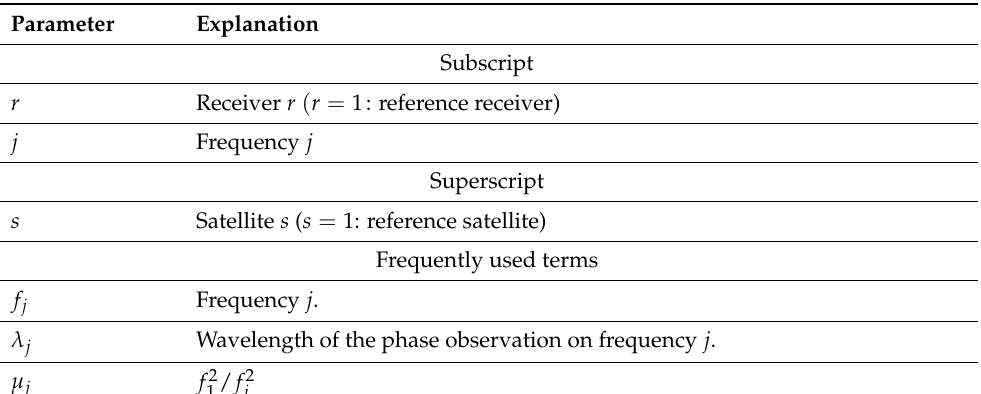
Table 2. Subscript, superscripts and frequently used